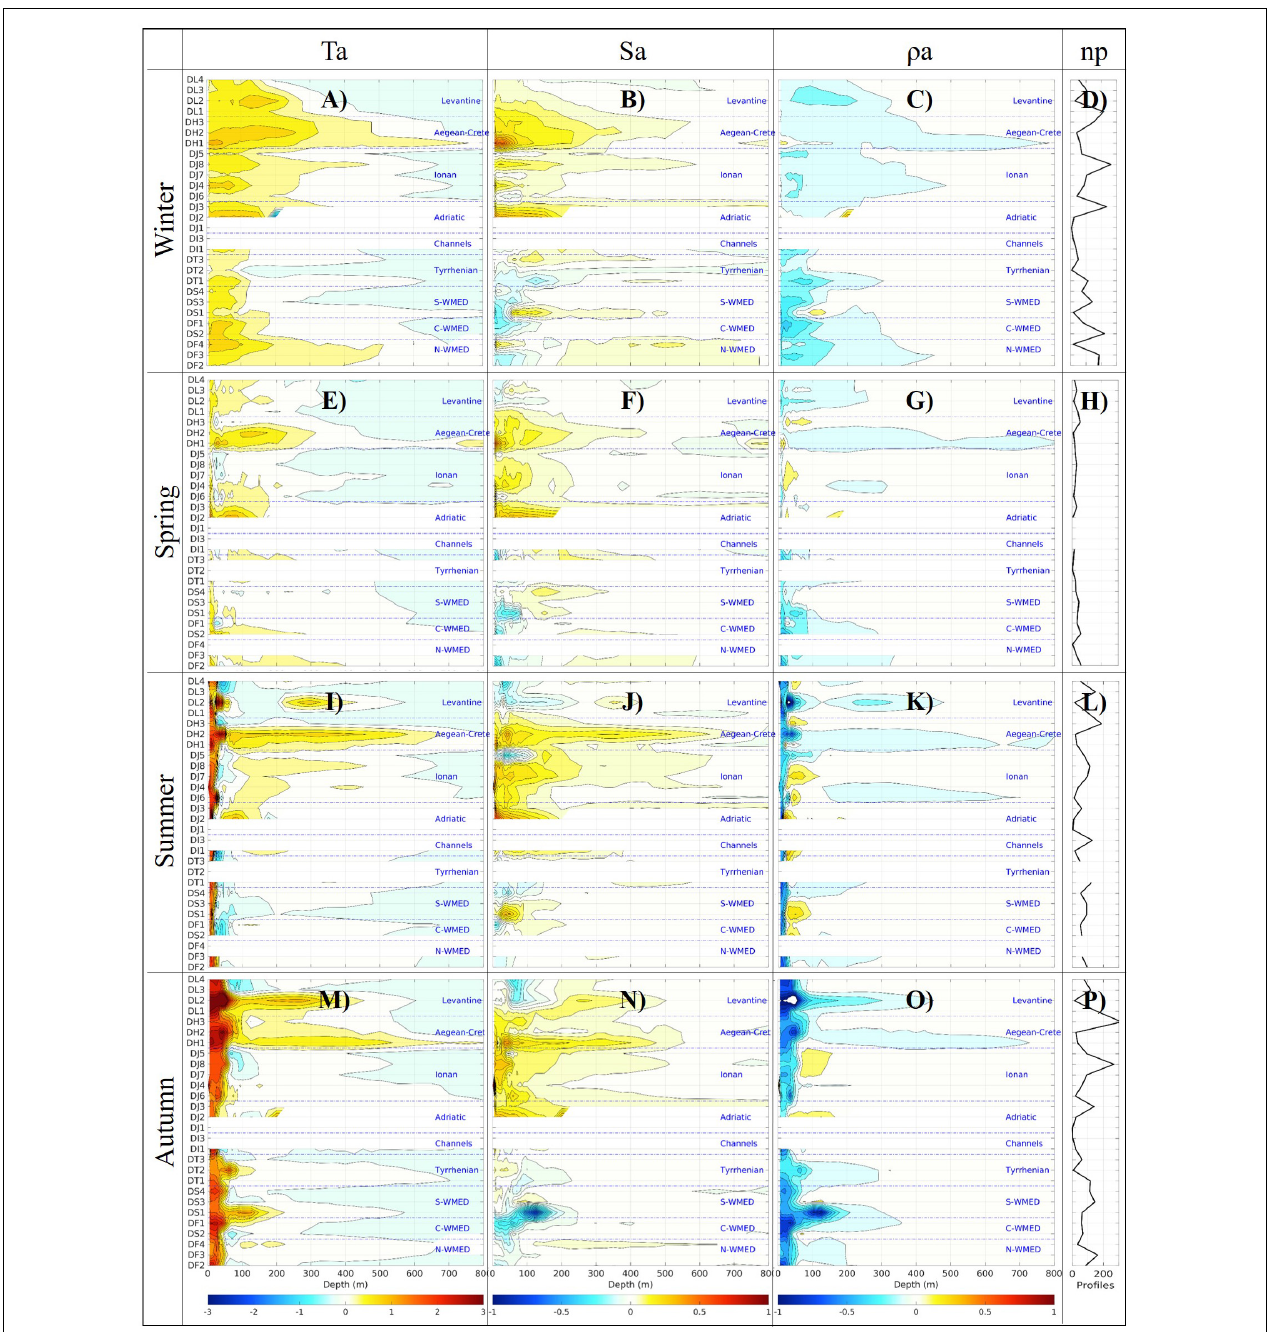
FIGURE 10 | Same as Figure 9 for temperature (A,E,I,M) , salinity (B,F,J,N) , and density (C,G,K,O) anomalies for the winters (A–C) , springs (E–G) , summers (I–K) , and autumns (M–O) over the period 2012–2020, and associated seasonal number of profiles [np] (D,H,L,P) .